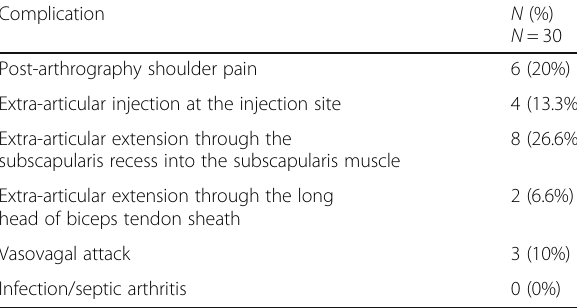
Table 7 Complications of